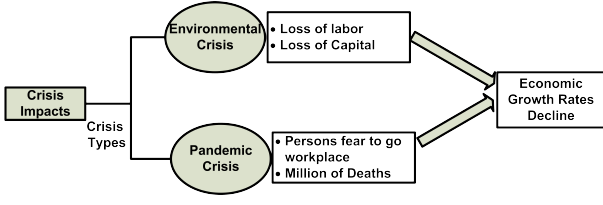
Figure 2. Crisis